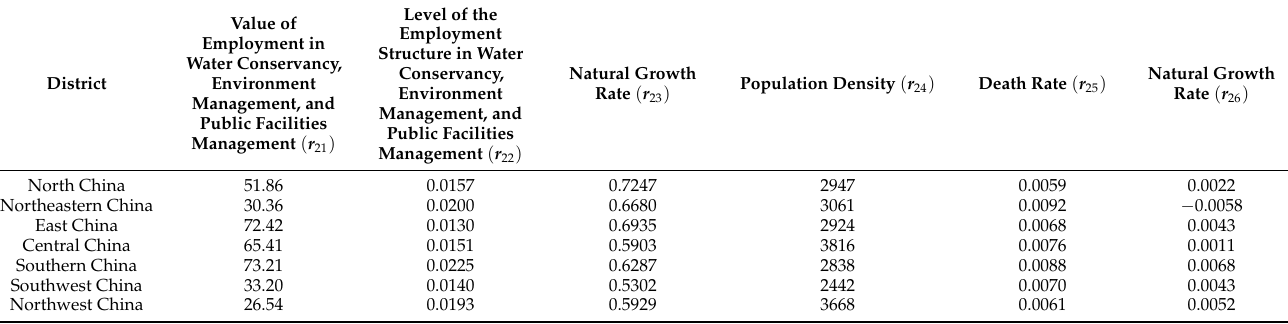
Table 4. Mean value of green infrastructure social function evaluation index in different